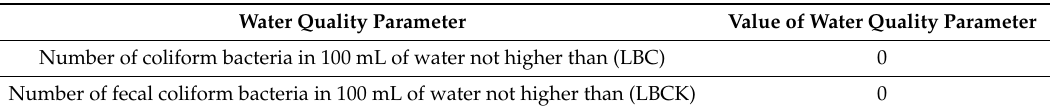
Table 1. (Normative) values of microbiological water quality parameters according to WHO Guidelines [48] used in the calculation